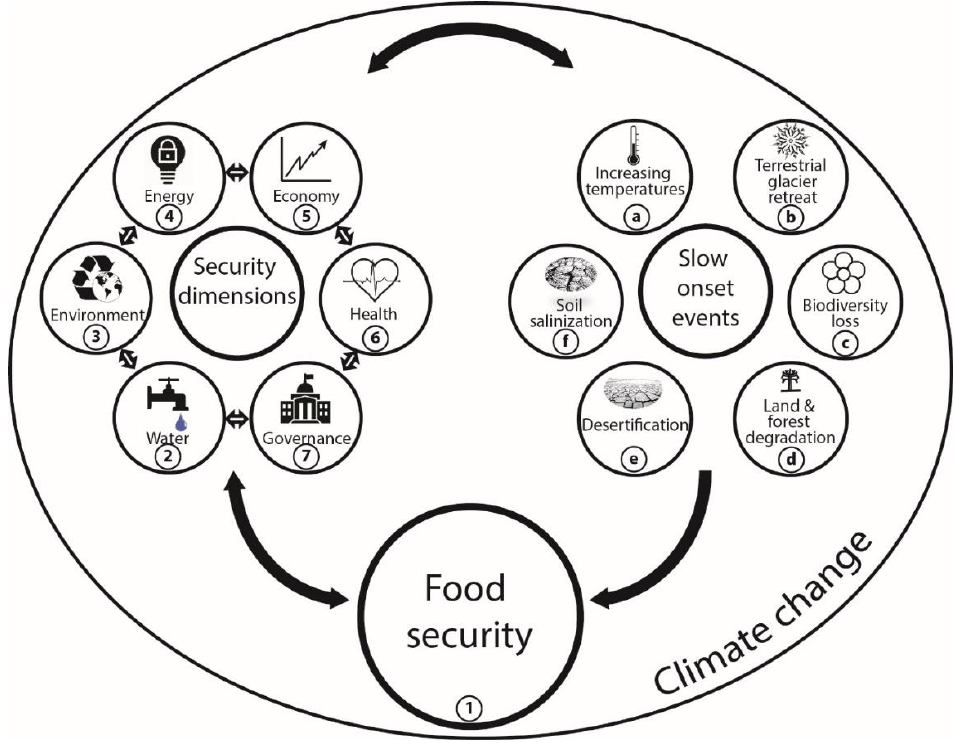
Figure 1. Interrelations among the factors affecting food security under climate change scenarios in drylands. Food security (1), which is strongly dependent on climate change, is interrelated with several dimensions, including water (2), environment (3), energy (4), economy (5), health (6), and their effective governance (7). These dimensions interact with each other, affect food security directly or indirectly, and are impacted by it. The slow onset effects/events (SOEs) — including increasing temperatures (a), (terrestrial) glacial retreat (b), biodiversity loss (c), land and forest degradation (d), desertification (e), and (secondary) salinization (f) — adversely affect food security and its dimensions. In turn, food security and its dimensions adversely affect these events.